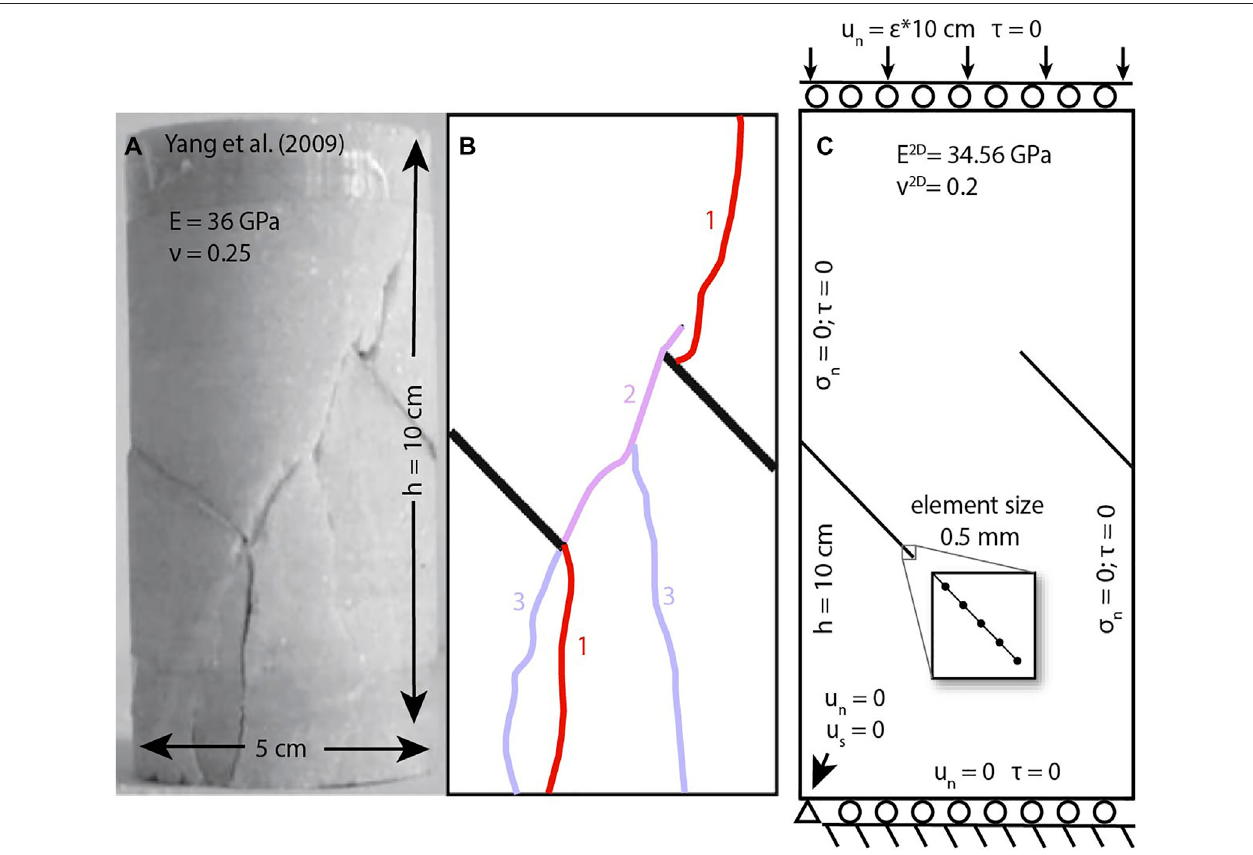
FIGURE 1 | (A) Post-experiment image of Yang et al. (2009) uniaxial compression experiment C with two pre-cut fractures in a cylindrical sample of marble 10 cm tall and 5 cm in diameter. The marble sample has a height, h, of 10 cm, diameter of 5 cm, an elastic modulus, E, of 36 GPa and a Poisson ’ s ratio, ν , of 0.25. (B) Map of fractures produced during Yang et al. (2009) uniaxial compression experiment C, labeled according to order of propagation. (C) 2D model setup used in this study to simulate experiment C. Applied material properties are scaled to 2D. Boundary conditions are shown according to prescribed normal and shear tractions ( σ n , τ ), and normal and shear displacements (u n , u s ) in terms of the lab experiment axial strain ( ε ).